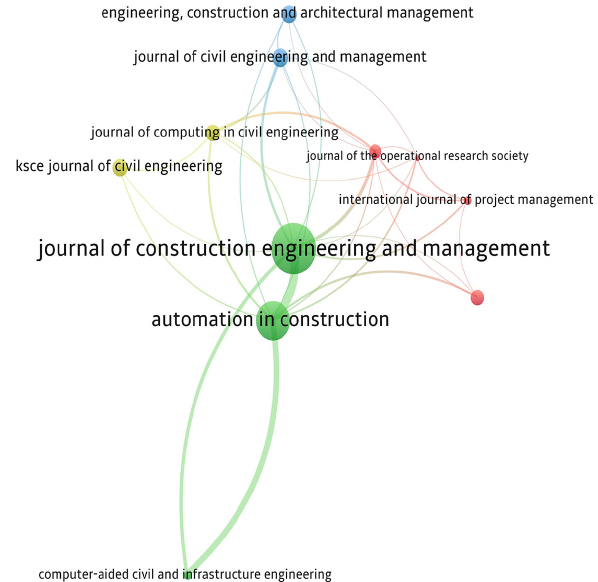
Figure 3. Science mapping of main influential journals in the domain of